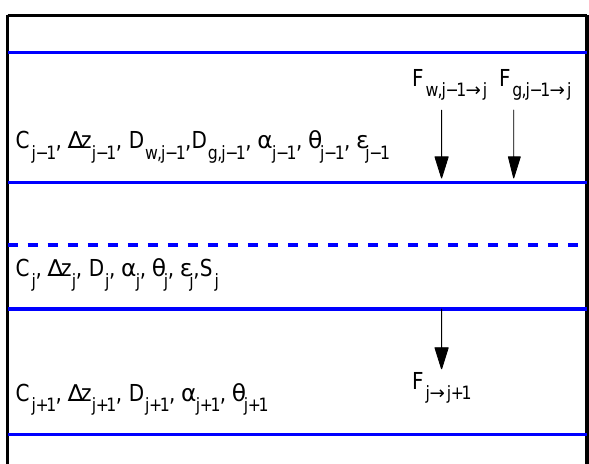
Table 1. An incomplete literature survey of different formulations that have been used for modeling dual-phase diffusive transport. Equation Remark (cid:16) (cid:17) ∂C CH4 ∂C CH4 = ∂ + S Bulk soil CH D i 4 concentration is the primary variable. Saturated and ∂t ∂z ∂z unsaturated soil use different but constant diffusivities D i . (cid:16) (cid:17) ∂C g = ∂ + S The gaseous phase is used as the primary variable. The model D ∂t ∂z ∂z assumes gas diffusion to dominate in unsaturated soil and aqueous diffusion to dominate in saturated soil. The water table is assumed to be at the layer interface. Diffusivity varies continuously with soil moisture. (cid:16) (cid:17) ∂C = ∂ + S Bulk tracer concentration is used as the primary variable. Diffusivity D ∂C ∂t ∂z ∂z varies continuously with soil moisture. Special care is put to the water–air interface. (cid:16) (cid:17) ∂C g ∂C g = ∂ + S g D g Tracks gaseous and aqueous phases of a given tracer separately. Gas ∂t ∂z ∂z (cid:16) (cid:17) dissolution and exsolution are considered explicitly. Diffusivity ∂C w = ∂ + S w D w ∂C w ∂t ∂z ∂z varies continuously with moisture.